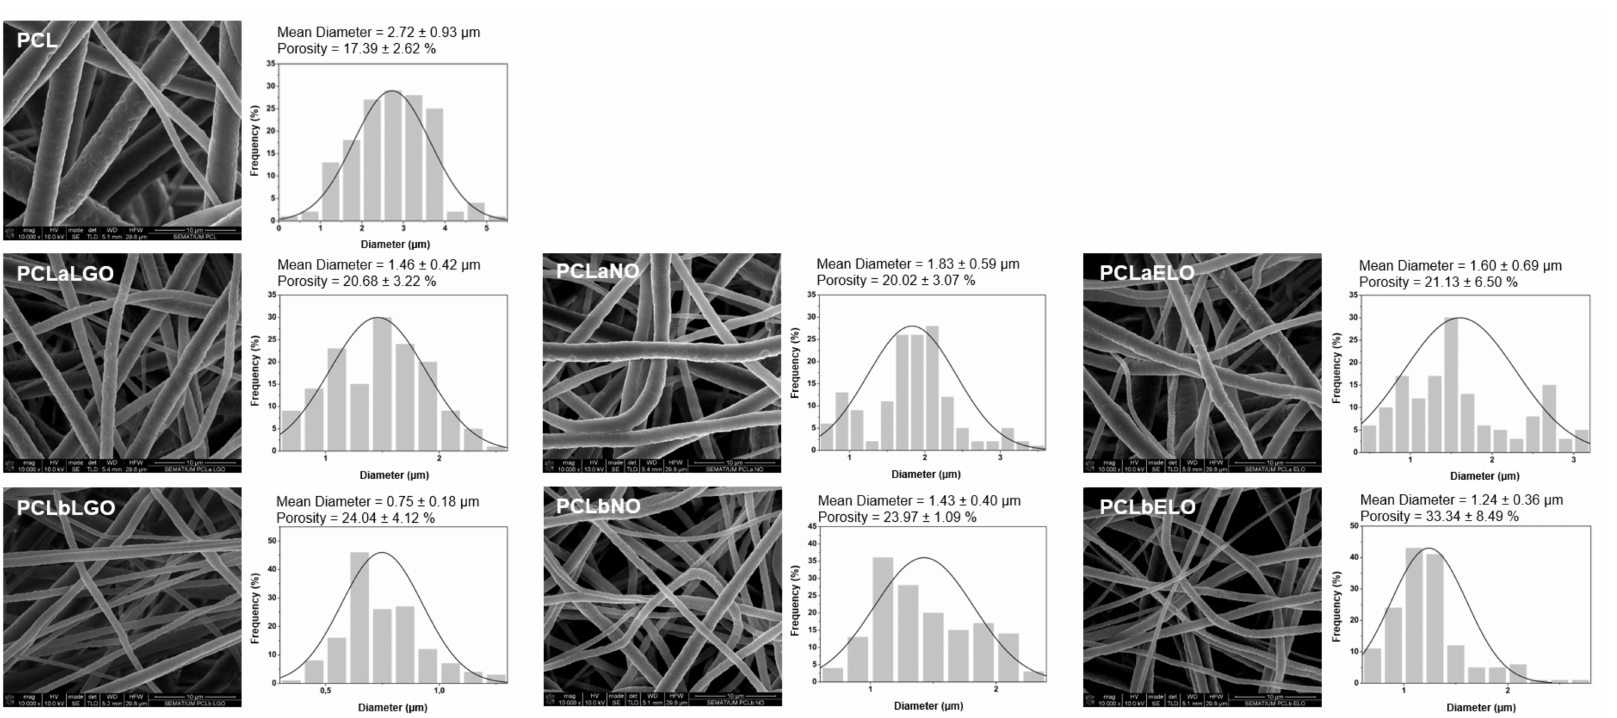
Figure 1. FEG-SEM micrographs and diameter distribution histograms of the PCL-based electrospun mats (unloaded, PCL; loaded with EOs by physical adsorption, PCLaLGO, PCLaNO and PCLaELO; and loaded with EOs by blending, PCLbLGO, PCLbNO and PCLbELO), with identification of average diameters and porosity. Scale bars in the micrographs represent 10 µ